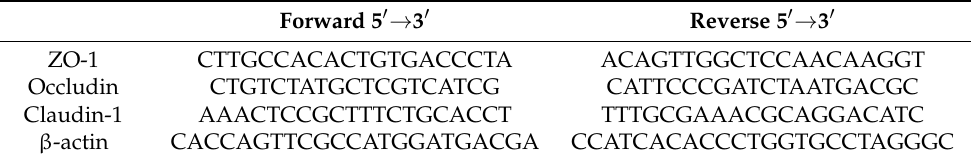
Table 9. List of primer sequences for analyzing related mRNA in this